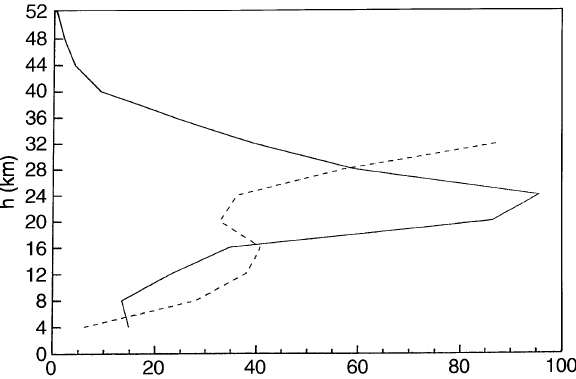
Fig. 3. 24 December 1992; solid line : O (cid:51) profile (10 (cid:49)(cid:49) molecu- lescm (cid:126)(cid:51) ); dashed line : zonal velocity profile (0.5 m s (cid:126)(cid:49) ) the lower stratosphere, while the meridional component is negligible (this curve is not plotted). Wind- and ozone- fields interaction leads to a marked O (cid:51) horizontal advec- tion along x with a very weak opposed effect of the velocity divergence term; in Fig. 4 the contribution of zonal advection to the ozone time change is shown as a function of